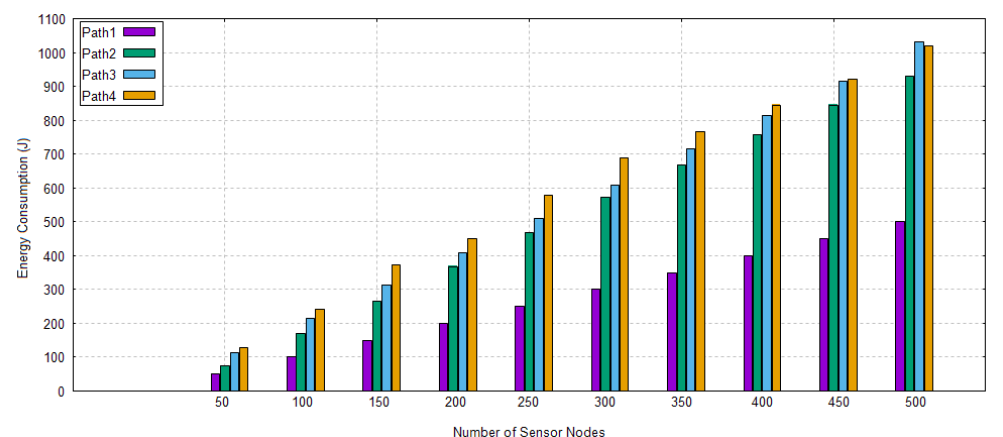
Figure 9. Energy Consumption of Different Paths in